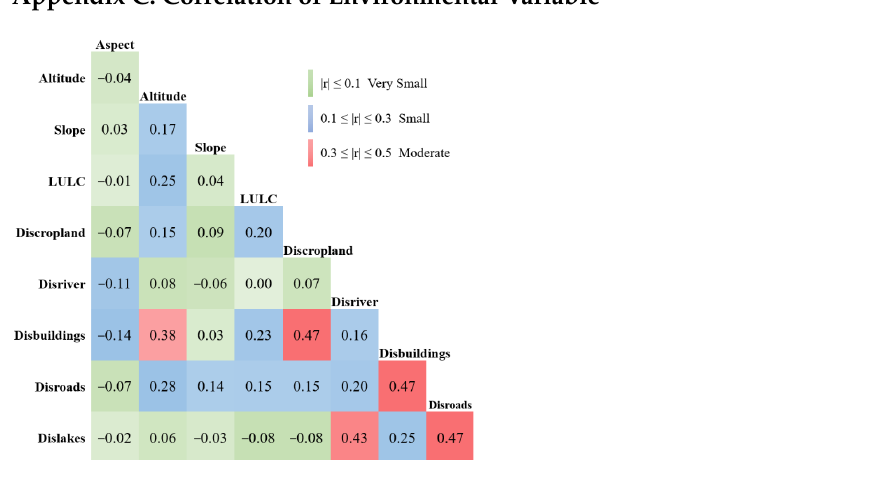
Figure A2. Location of line transects and camera-trapping in the Qilian Mountains. Field study was mainly carried out at Xianmi, Sigou (A) and East Qilian (B).